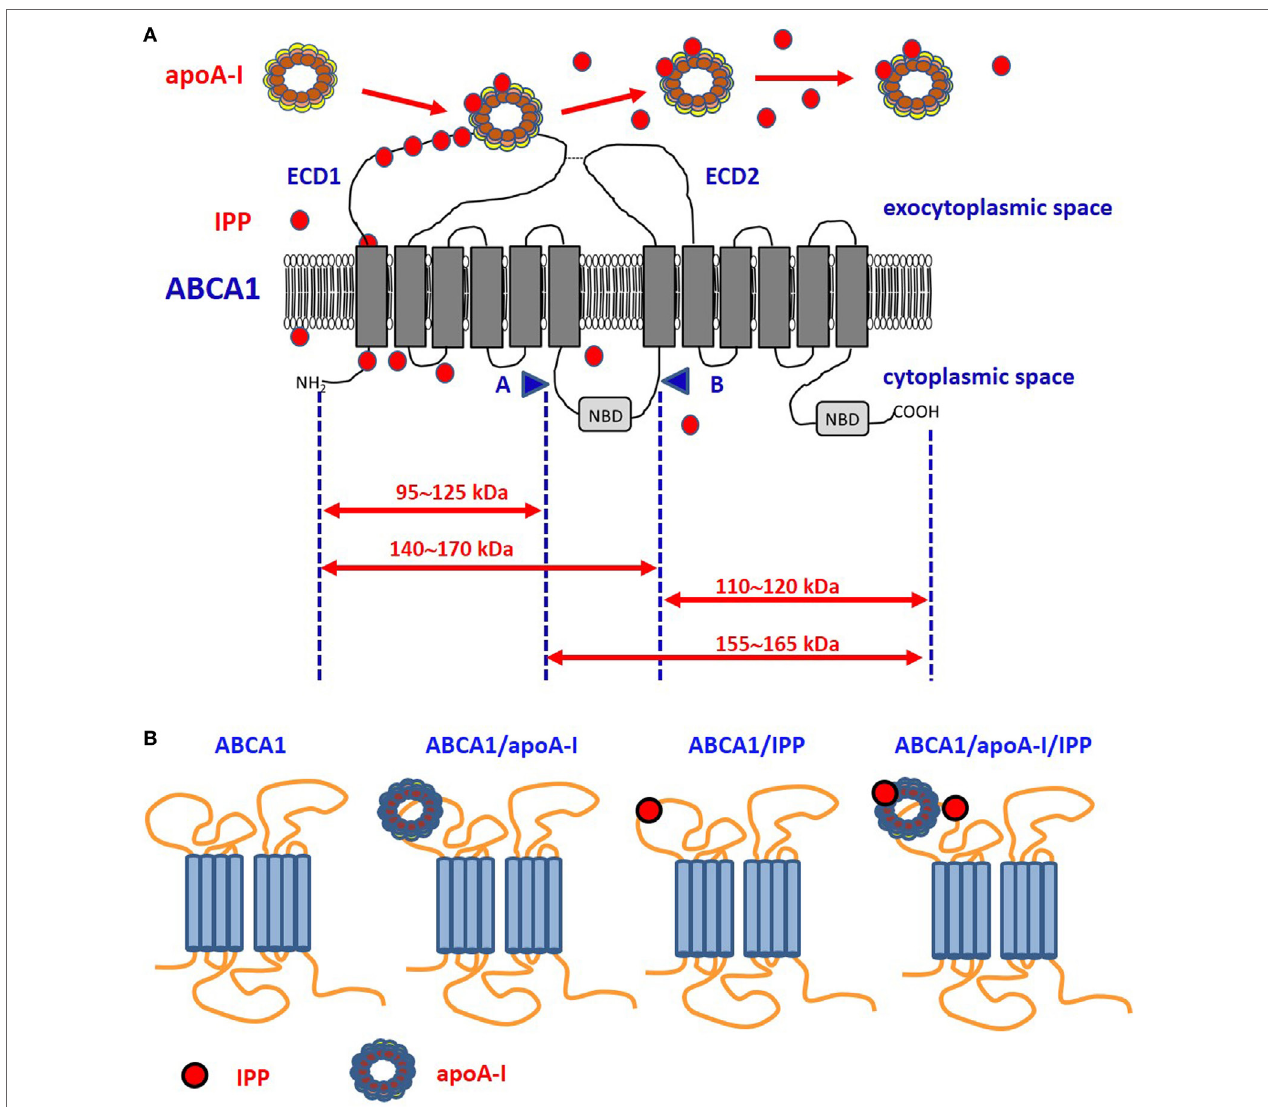
FiGURe 1 | Proposed model of ABCA1, apoA-I, and isopentenyl pyrophosphate (IPP) interactions . (A) It is unknown whether intracellular IPP binds to intracellular ABCA1 domains as it does with the intracellular B30.2 domain of BTN3A1 (see Figure 2 ). IPP is extruded across ABCA1 pore and reaches the extracellular environment. Limited trypsin-digestion cleaves ABCA1 into four fragments, corresponding to different extracellular and intracellular domains (51). The schematic diagram of trypsin-limited digestion of ABCA1 and the molecular sizes of the fragments produced are shown. We have found that IPP is associated with the amino-terminal extracellular portion of ABCA1 (31). Interestingly, apoA-I has been reported to interact with the same portion (52). We propose that IPP and apoA-I meet and associate within the amino-terminal portion of ABCA1 in the ECD1. IPP locally competes with cholesterol and other phospholipids for apoA-I binding and transportation. Local concentrations and the oxidized status of apoA-I, especially if IPP-producing cells are embedded in an inflammatory microenvironment, may favor IPP binding vs other metabolites. It is also possible that IPP is released in the extracellular space unbound to apoA-I. It is currently unknown whether IPP/ apoA-I is more resistant to degradation by serum nucleotide pyrophosphatases than soluble IPP and more effective in the activation of V γ 9V δ 2 T cells faraway from IPP-producing cells. (B) ABCA1 is schematically represented from left to the right without any extra-loaded molecule, loaded with apoA-I only, with IPP only, and with IPP/apoA-I + IPP. It has been shown that apoA-I and IPP can bind to ABCA1, and that ABCA1 can bind to BTN3A1 (31). It is currently unknown whether ABCA1 has different affinity for BTN3A1 depending on IPP and/or apoA-I loading. Arrows: moleculare weight of fragments derived from trypsin-cleavage sites; COOH, carboxyterminal domain; ECD1, extracellular domain 1; ECD2, extracellular domain 2; NBD, nucleotide binding domain; NH2, amino-terminal